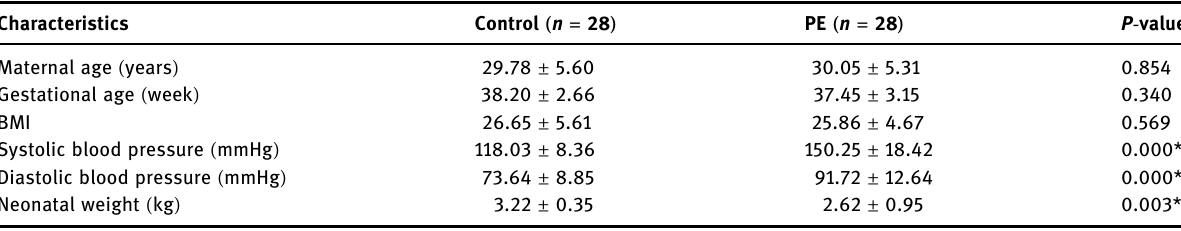
Table 1: Clinical characteristics of the study samples